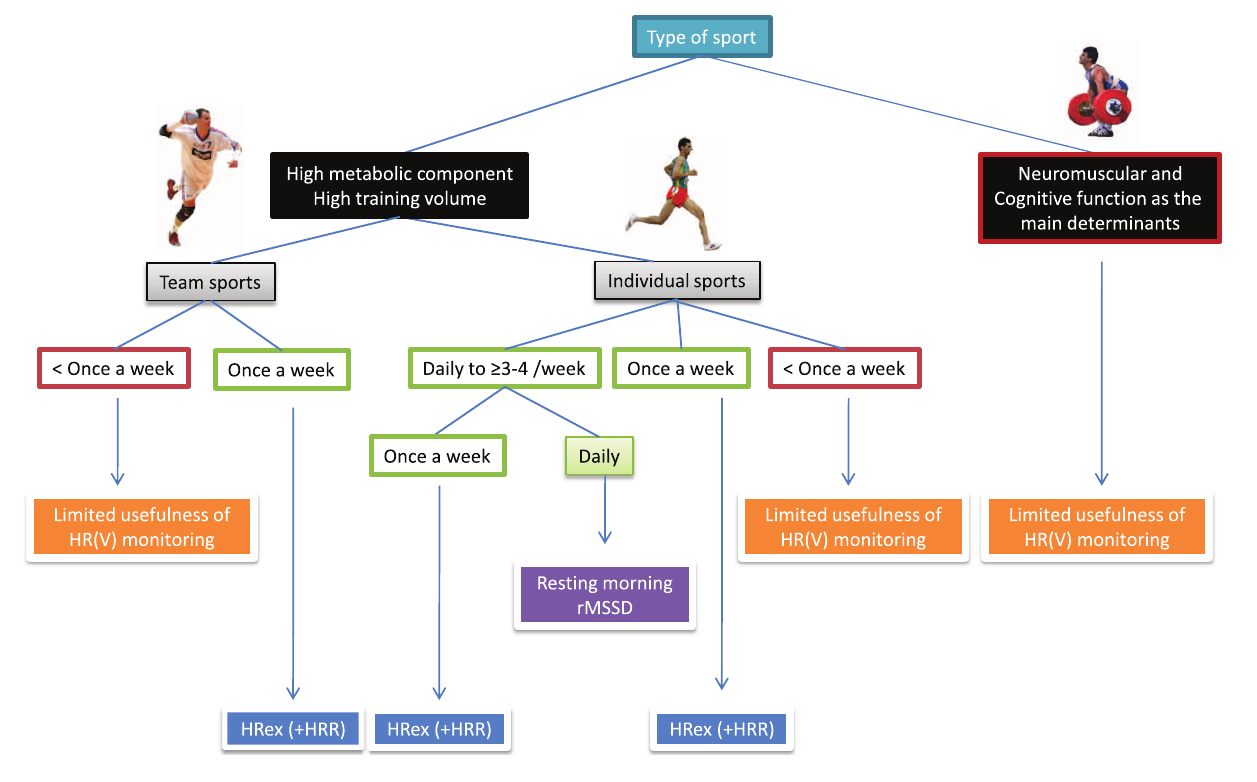
FIGURE 8 | Decision chart for the selection of heart rate (HR) measures based on sport participation and implementation possibilities. HRV, heart rate variability; rMSSD, logarithm of the square root of the mean of the